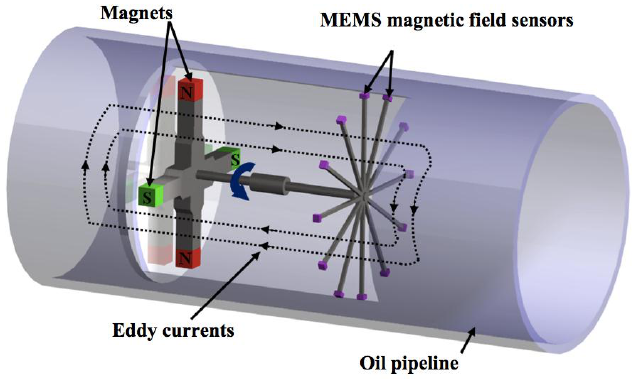
Figure 22. Design of a flaws inspection system in oil pipeline using Eddy current technique [36]. Reprinted with permission from [36]. Copyright© 2011, InTech.